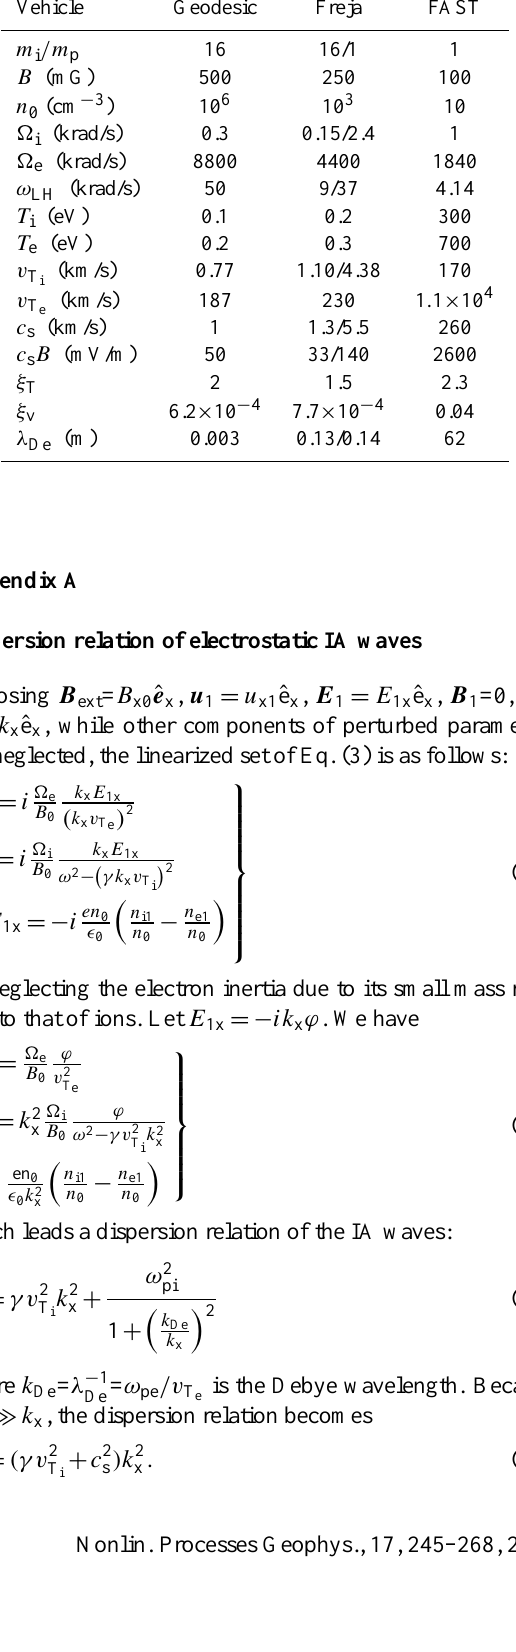
Vehicle Geodesic